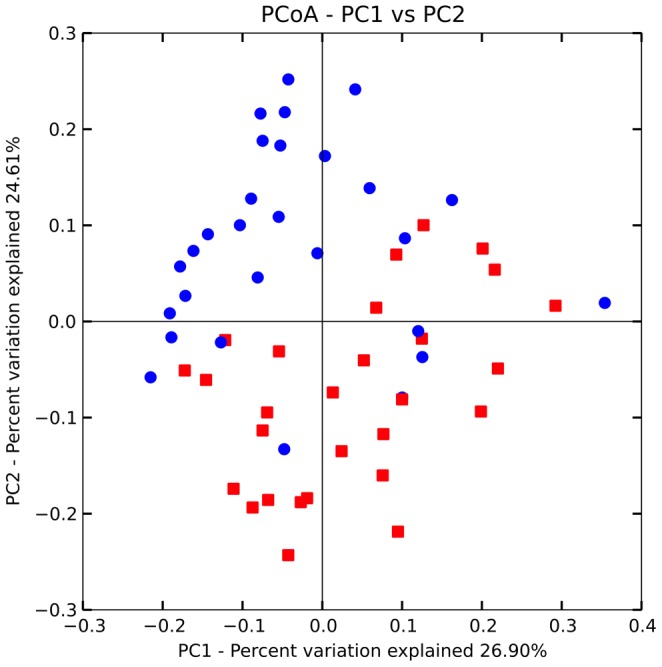
Principal Coordinates Analysis of weighted UniFrac distances for 16S rRNA gene sequence data.The distribution shows distances within and across normal-weight (N, red ▪) and obese (O, blu •) subjects populations on the basis of the microbiota.